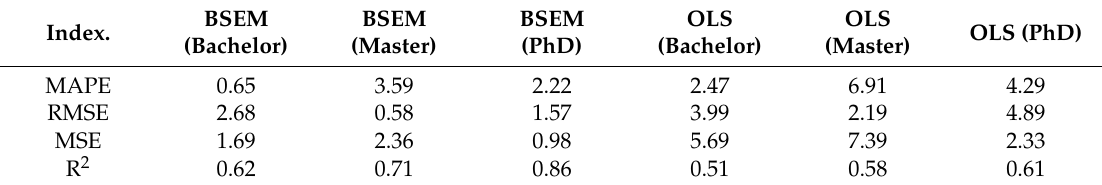
Table 7. Comparison of BSEM (Bayesian Structural Equation Modelling) and OLS index results in different models.